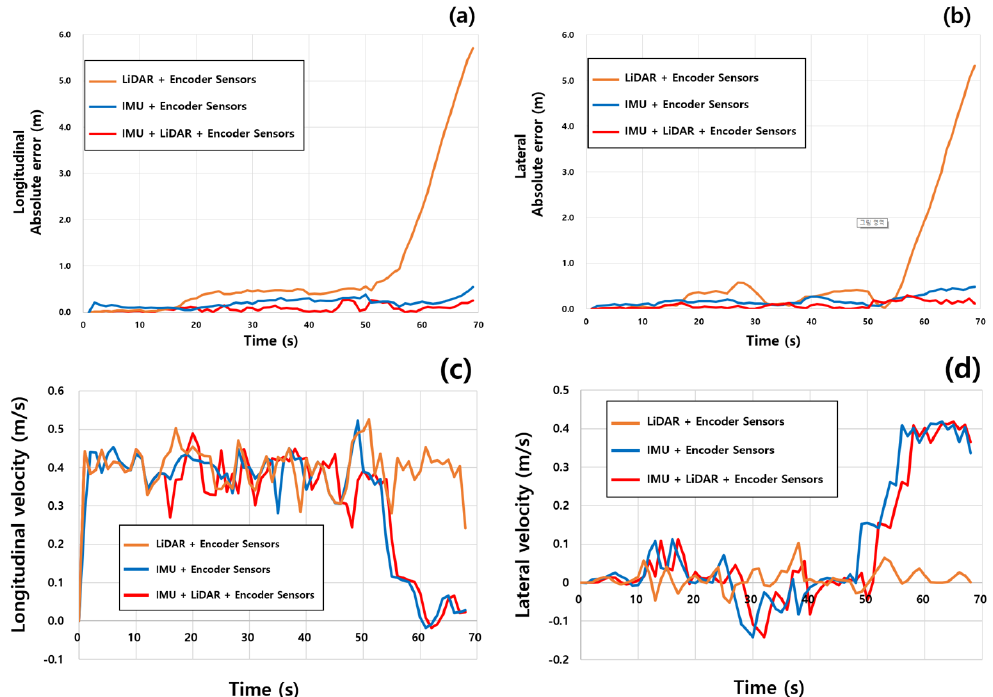
Figure 9. Comparison of the longitudinal and lateral absolute errors (( a ) and ( b )) and the longitudinal and lateral velocities (( c ) and ( d )) between the three (LiDAR + encoder, IMU + encoder, and IMU + LiDAR + encoder sensors) location estimation methods.